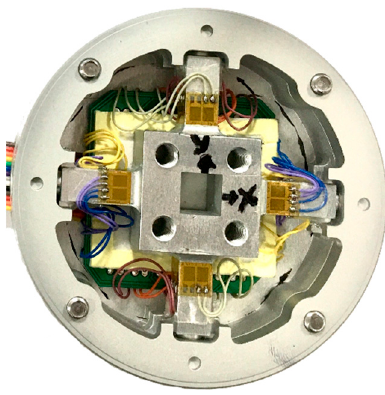
Figure 13. Proposed sliding F/M sensor.